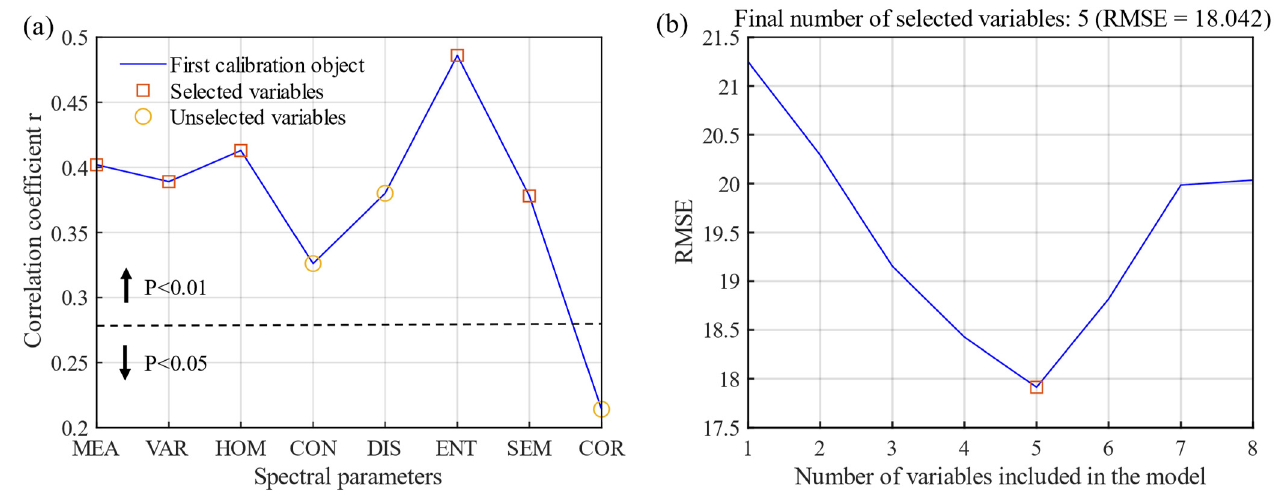
Figure 7. Correlation ( a ) between texture feature parameter and disease index (DI) and the root mean square error ( b ) for the optimal variables selected using SPA.